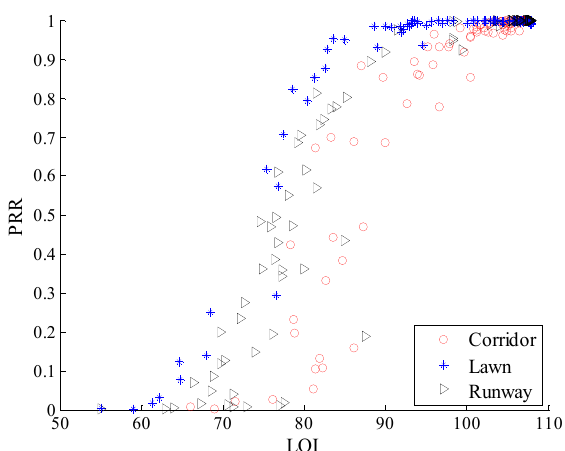
Figure 21. µ lqi vs. PRR in di ff erent environments.